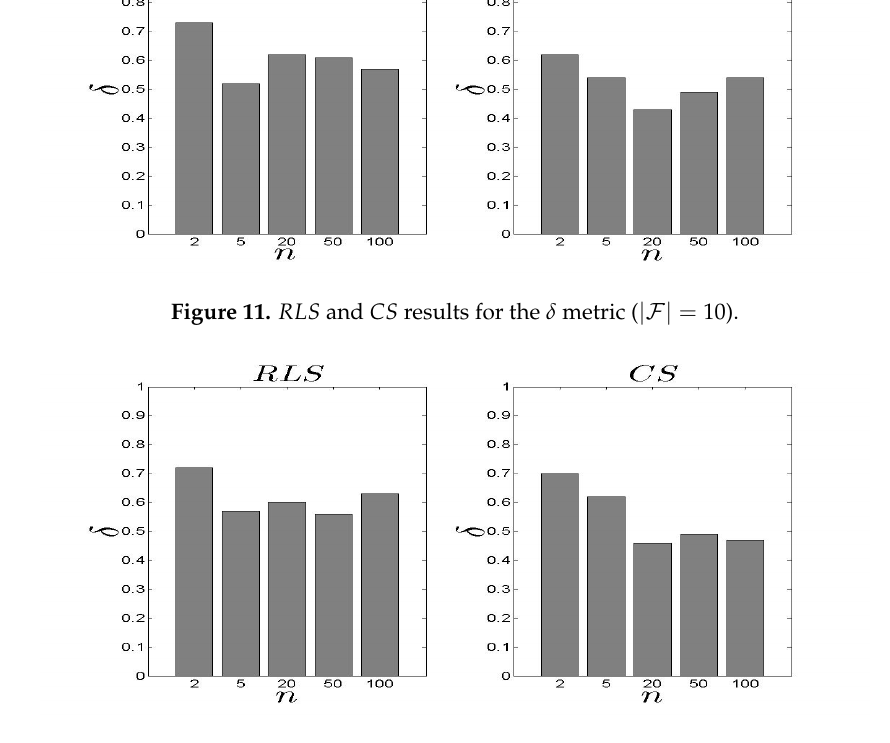
Figure 12. RLS and CS results for the δ metric ( |F| =